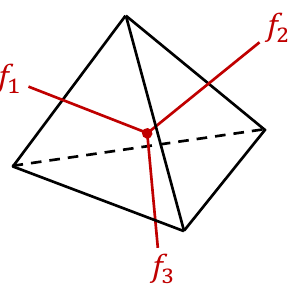
, f , f on a tetrahedron, there 1 2 3 = − U [ 42 ] . Therefore, we conclude that U U U U f 1 f 2 f 3 f 3 f 2 f 1